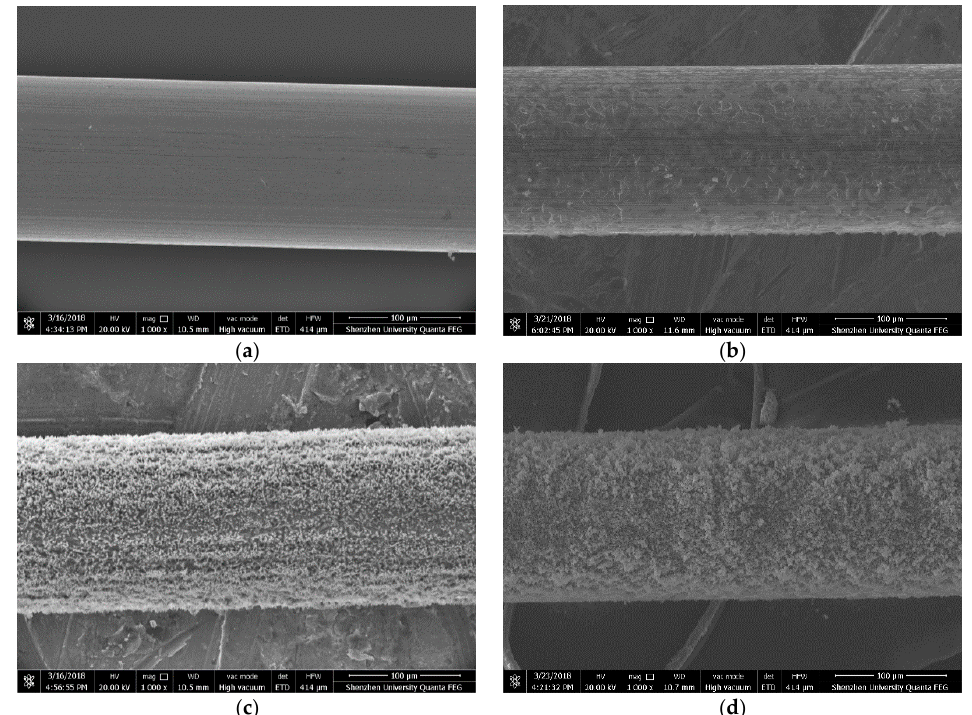
Figure 13. SEM images of steel wires, ( a ) without passivation, ( b ) 1-day passivation, ( c ) 7-day Figure14. SEMimagesofsteelwires, ( a )withoutpassivation, ( b )1-daypassivation, ( c )7-daypassivation, passivation, and ( d ) 11-day passivation. and ( d ) 11-day